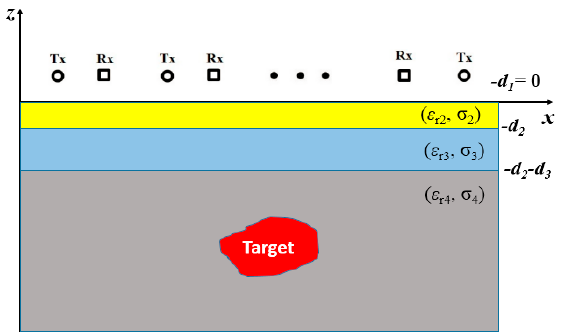
Figure 1. Radar imaging through stratified subsurface media [21].